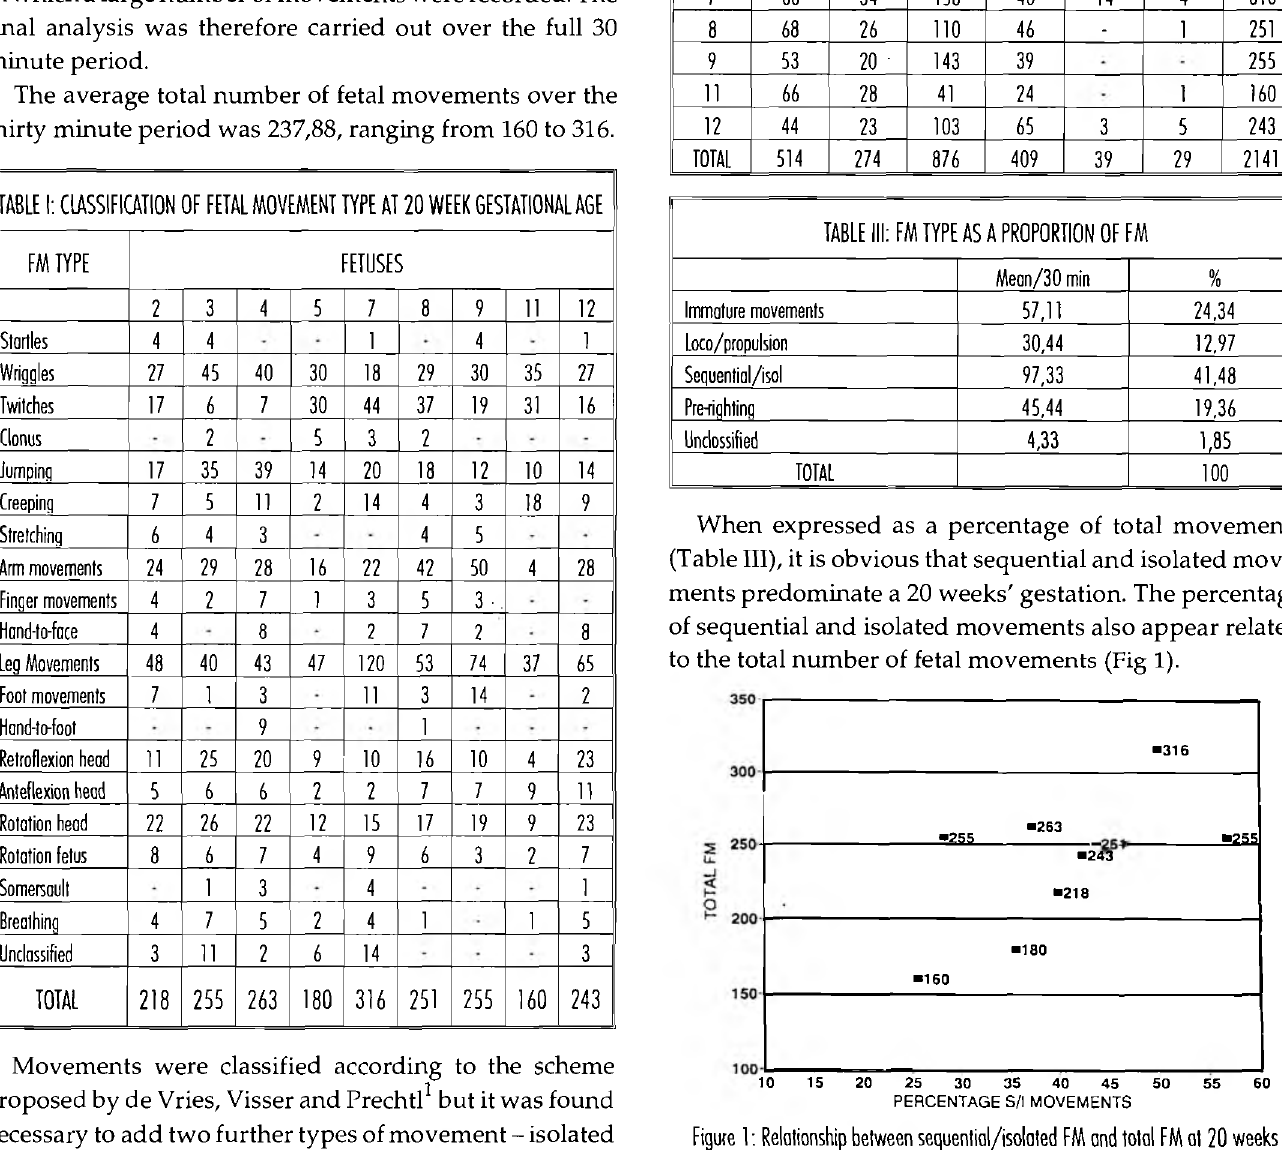
Figure l : Relationship between sequential/isolated FM and total FM at 20